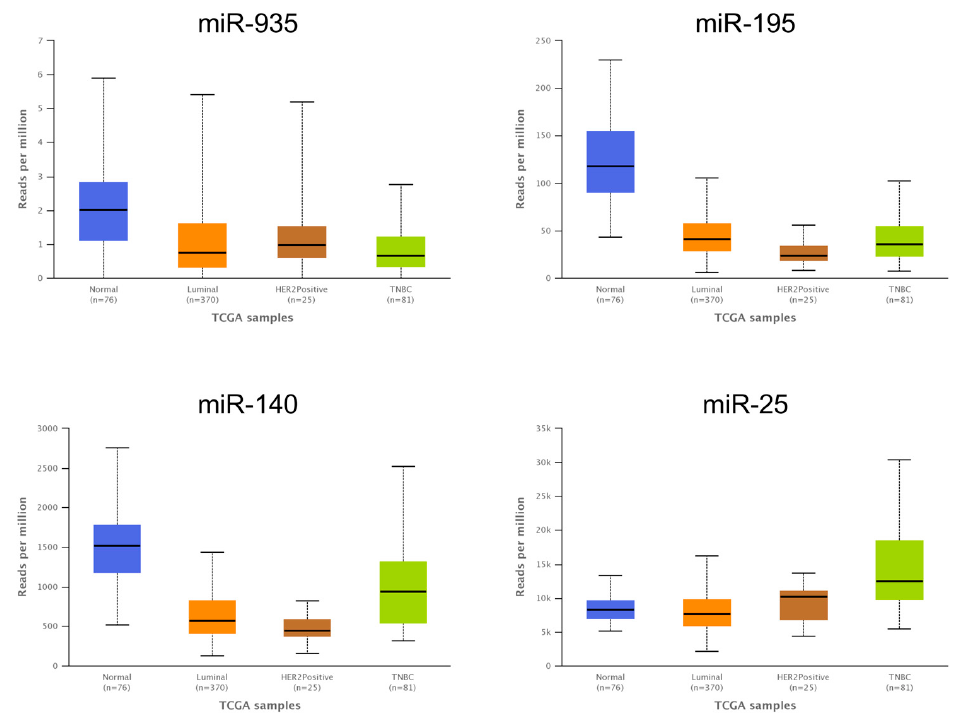
Figure 7. Comparison of the expression of four miRNAs downregulated in Hs578T 3D cultures against the expression reported in biopsies from breast cancer tumor subtypes according to TGCA databases. Bar graph showing expression levels of the four miR-935, miR-195, miR-140, and miR-25 in breast cancer subtypes compared to normal tissues ( n = 76) from TCGA (RNAseq experiments). Y -axis shows reads per million according to RNAseq analysis. X -axis indicates the breast cancer subtypes (Luminal n = 370, HER2-positive n = 25, triple negative n =